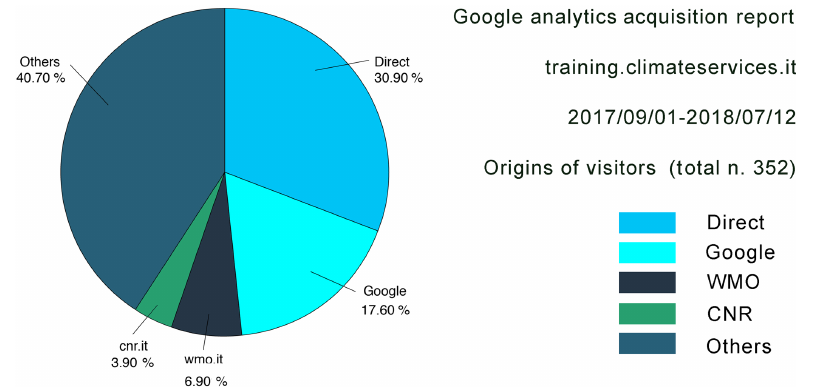
Figure 2. Google Analytics Report September 2017–July 2018 of referrals to the TOP Course